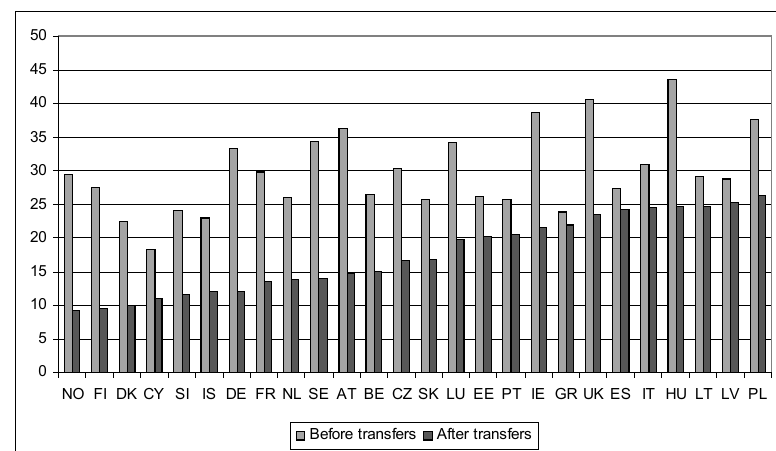
Figure 11 : Child poverty rates before and after transfers